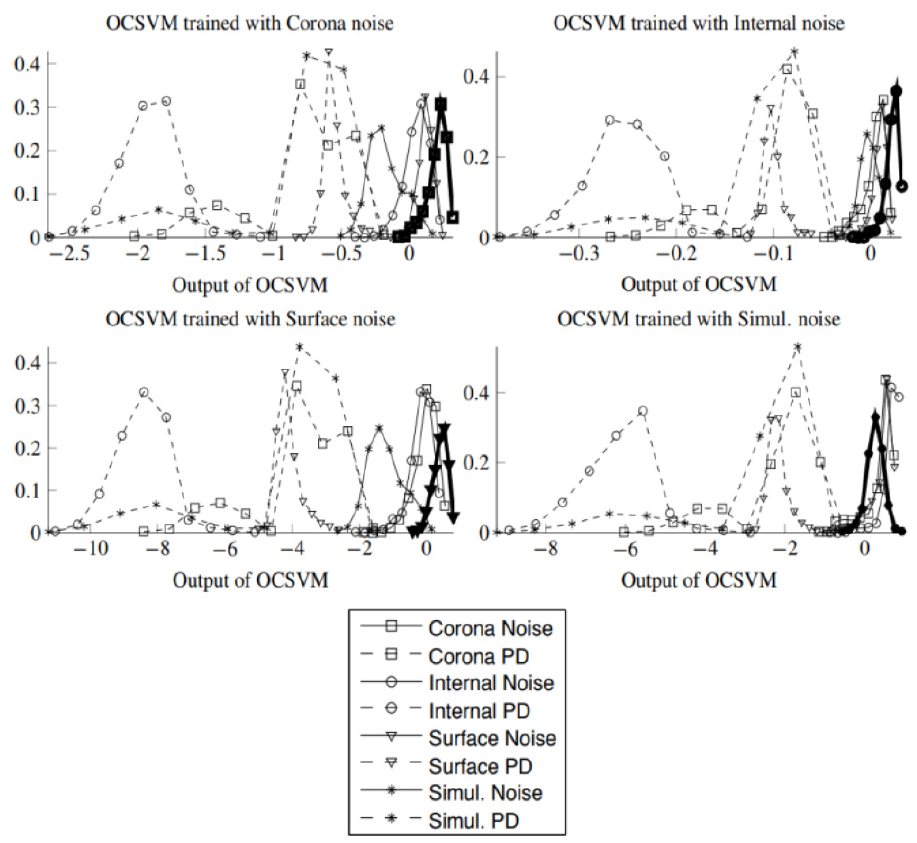
Figure 6. Normalized histograms of the output of the OCSVM trained with the background noise examples when the test signals are either default mode signals or PD from the different experiments. The histogram corresponding to the class of the training set is plotted with double line width.